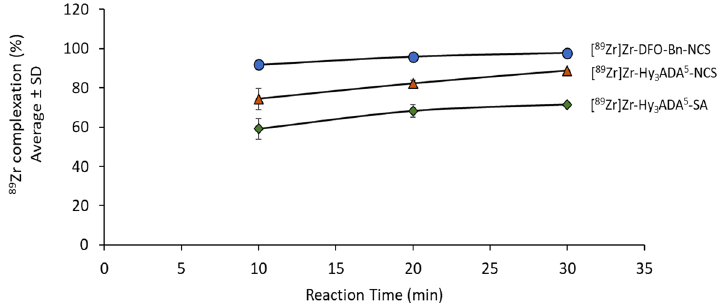
Figure 2. Percentage of 89 Zr complexation with DFO-Bn-NCS, Hy 3 ADA 5 -NCS and Hy 3 ADA 5 -SA at different reaction times.